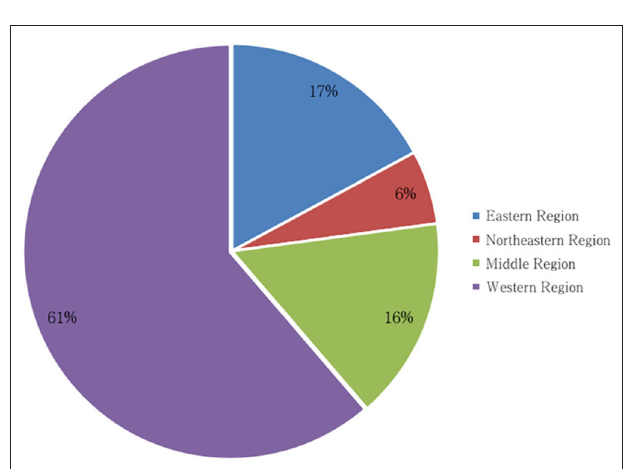
FIGURE 2 | The regional distribution of wildlife